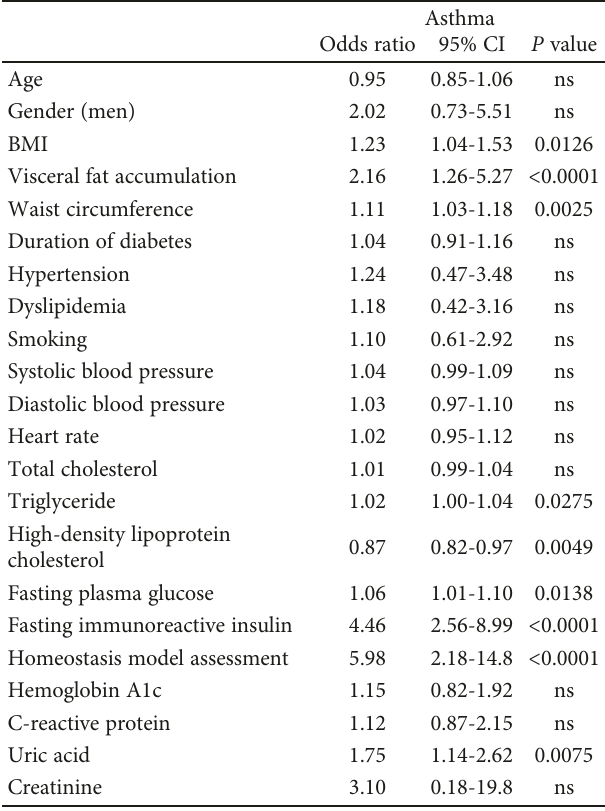
Table 2: Univariate logistic regression analysis of the relationship between asthma (dependent variable) and other parameters in patients with type 2